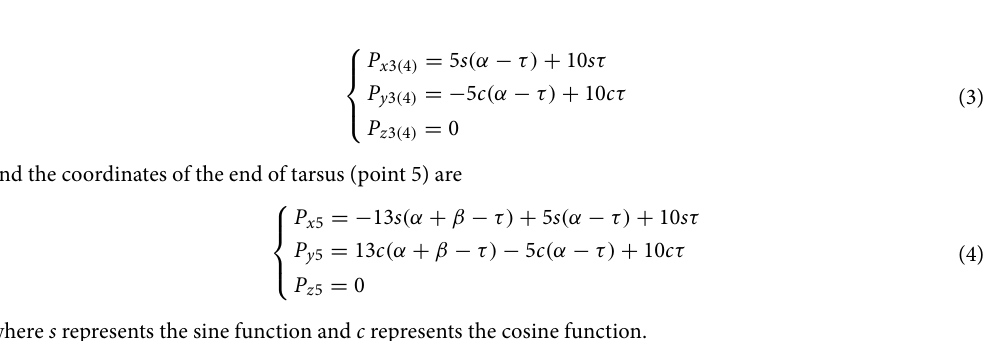
Figure 7. The speed of the diving beetle in the three movement modes: (a) velocity of the diving beetle during forward motion: the speed of diving beetle rapidly increased then rapidly decreased during the power stroke, and remained stable in the recovery stroke; (b) angular velocity of the diving beetle during turning motion: the angular velocity of diving beetle increased rapidly then decreased during the power stroke, and continued to decrease during the recovery stroke; (c) velocity of the diving beetle during retreating motion: the speed of the diving beetle increased rapidly during the power stroke and gradually decreased during the recovery stroke (SIMI Motion 2007, www. simi. com, the carrier of the software is a